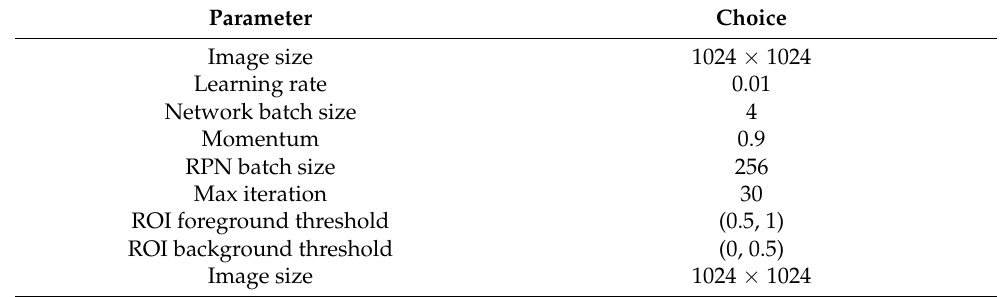
Table 2. Parameter details.